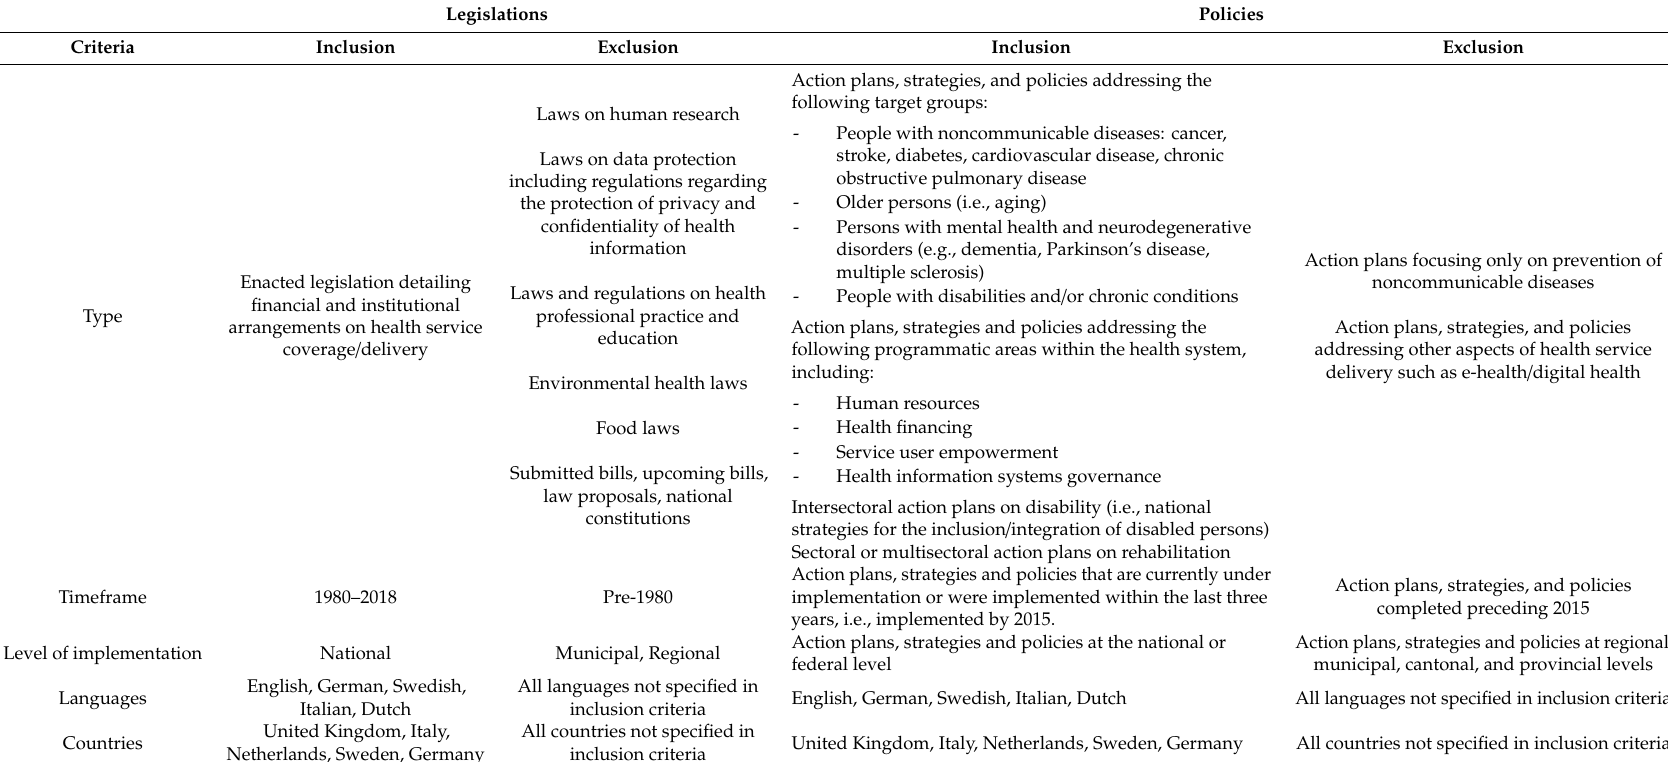
Table 2. Inclusion and exclusion criteria for retrieval of health legislation and health